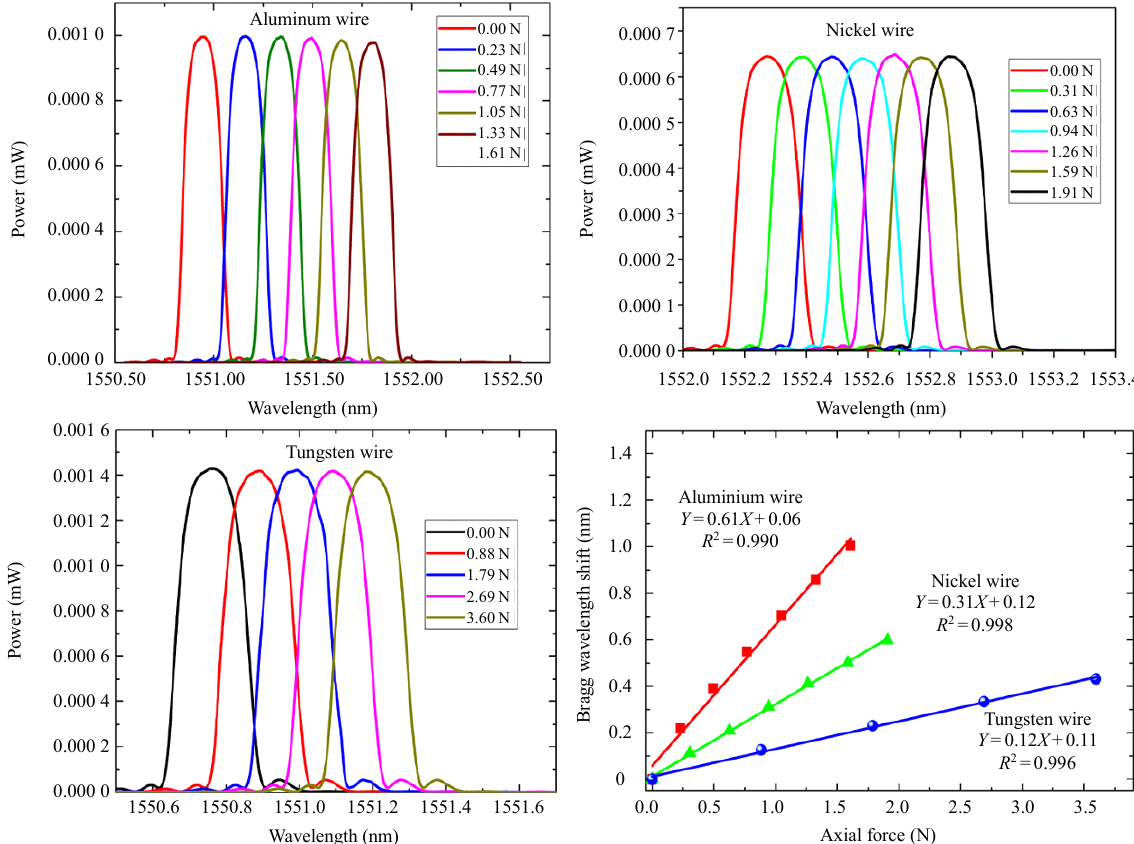
Fig. 5 FBG reflective spectra shift with the change of the axial forces: (a) aluminum wires, (b) nickel wires, (c) tungsten wires, and (d) the Bragg wavelengths of FBG response to the variation of the loaded axial